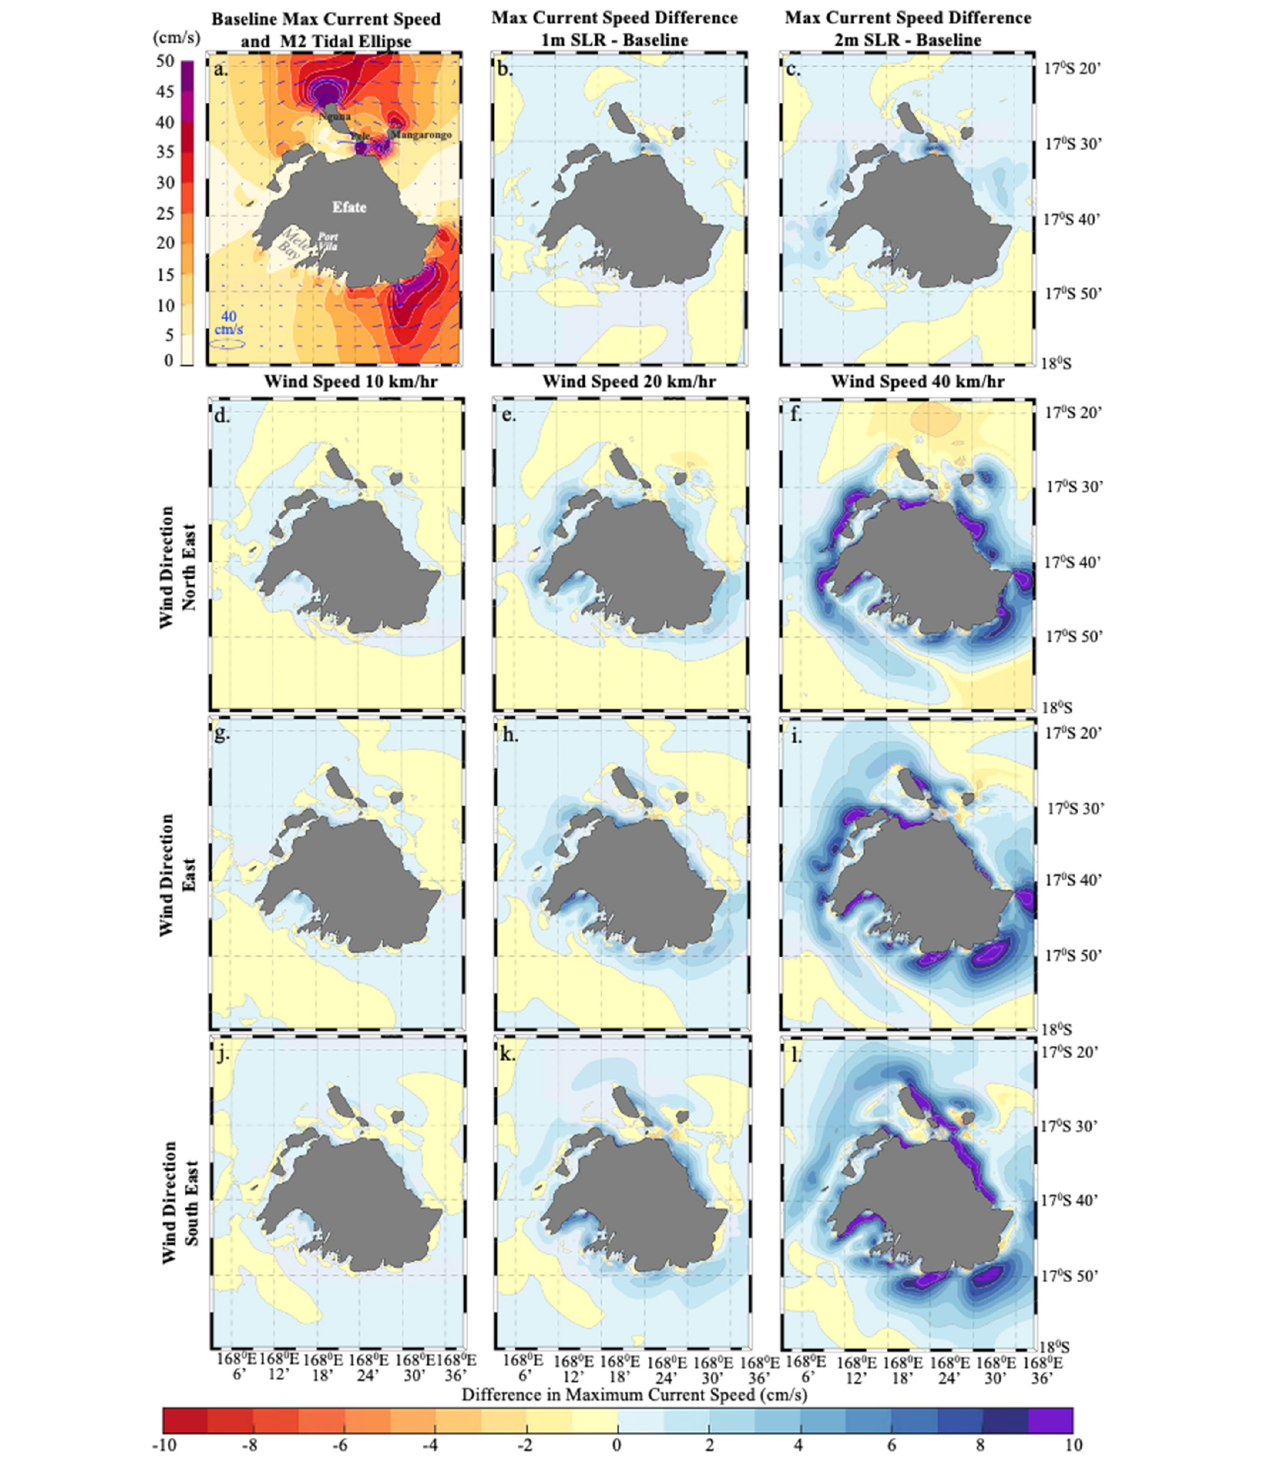
FIGURE 5 | Baseline maximum depth-averaged current speeds around Efate Island, Vanuatu shown underlying M2 tidal ellipses, with white isolines at 5 cm/s intervals (a) . Change in maximum depth-averaged current speeds (cm/s) under 1 m SLR (b) and 2 m SLR (c) . Change in maximum depth-averaged current speed (cm/s) under 10 km/h (d) , 20 km/h (e) , and 40 km/h (f) northeast winds. Change in maximum depth-averaged current speed under 10 km/h (g) , 20 km/h (h) , and 40 km/h (i) east winds. Change in maximum depth-averaged current speed under 10 km/h (j) , 20 km/h (k) , and 40 km/h (l) southeast winds. Light grey isolines (b–l) indicate 2 cm/s intervals. Latitudes are displayed to the right of panels (c,f,i,l) . Longitude for all panels are displayed below panels (j–l) .